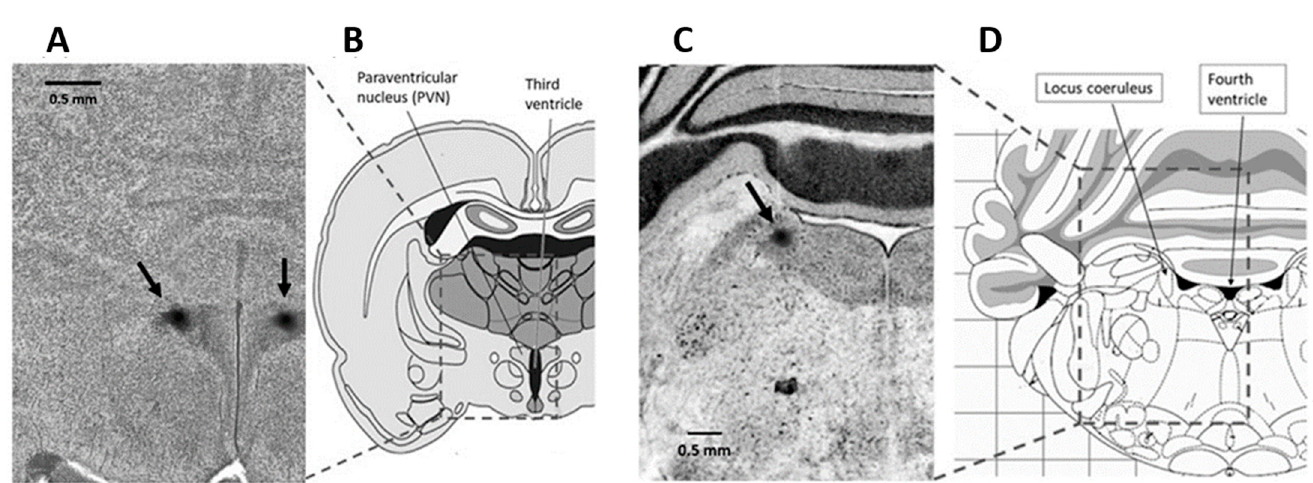
Figure 8. Photomicrographs of rat brain coronal, transverse sections (scale bar = 0.5 mm) showing stereotaxic dye labeling (see arrows) in the PVN ( A ) and the LC ( C ), alongside a diagrammatic representation of rat brain sections allowing to situate the PVN and the LC in specific regions of the hypothalamus ( B ) and the brainstem ( D ), respectively.